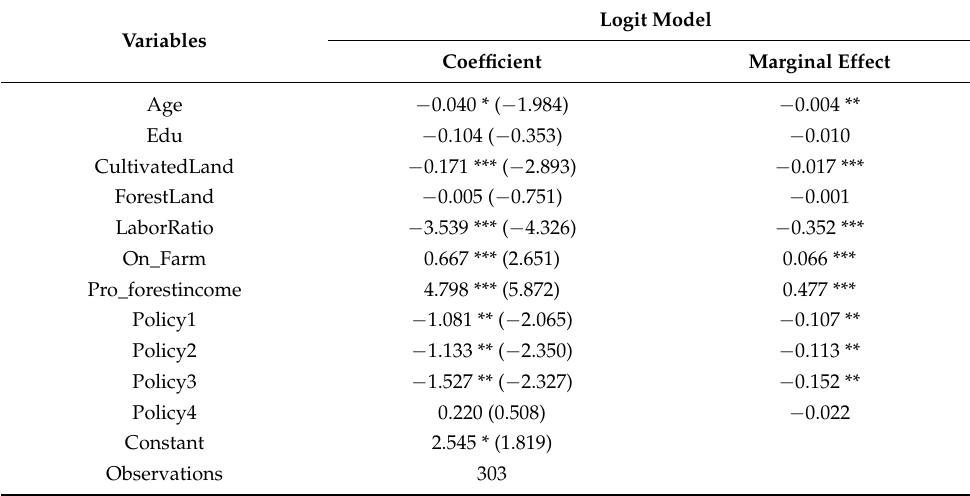
Table 8. The Logit regression result under the 50% relative poverty